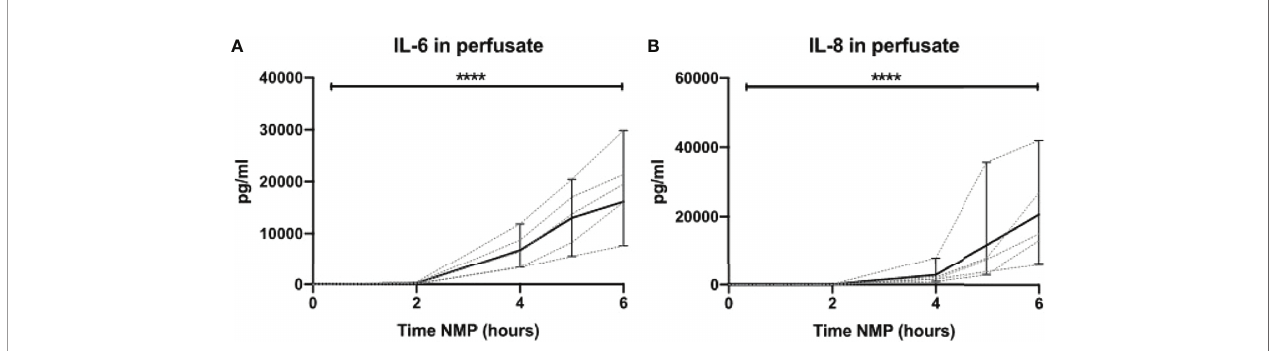
FIGURE 10 | Cytokine perfusate levels during normothermic machine perfusion of human discarded kidneys. Dynamics of pro-in fl ammatory cytokines (A) IL-6 and (B) IL-8 in perfusate during normothermic machine perfusion of human discarded kidneys. Cytokine perfusate levels signi fi cantly increased during 6 h of normothermic machine perfusion. Dotted lines: increase of cytokine levels in perfusate per individual perfused kidney. Solid lines and bars: median ± interquartile range of cytokine perfusate levels for all kidneys ( n = 10). **** p < 0.0001. IL-6, interleukin-6; IL-8, interleukin-8; NMP, normothermic